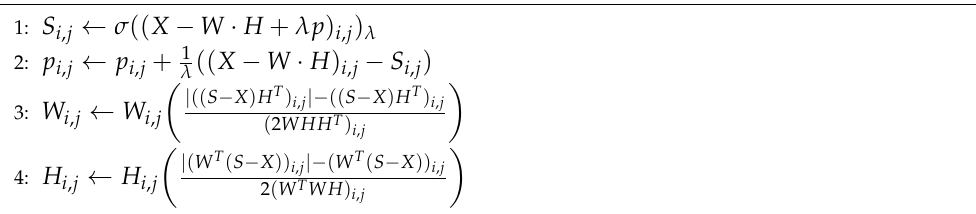
Algorithm 1 Update step of W, H, S and p for muscle